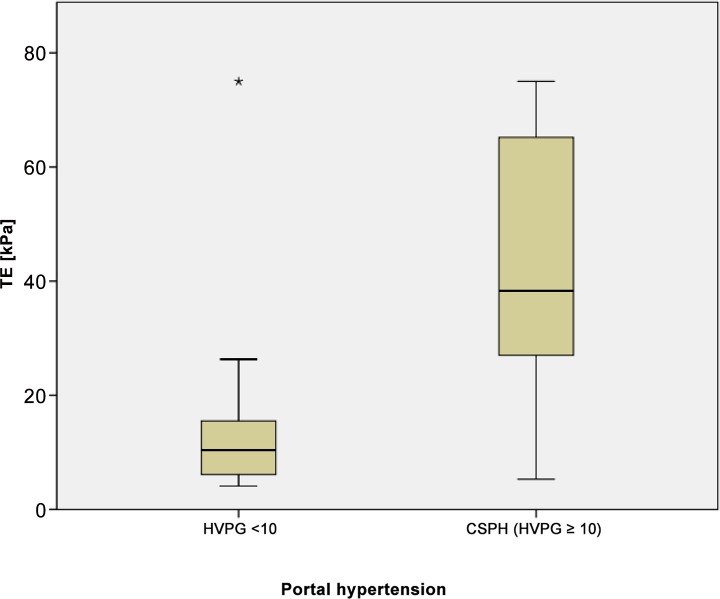
Correlation of transient elastography (TE; kPa) and CSPH.Mean values of TE shown in boxplots for a cohort of patients with and without CSPH each.